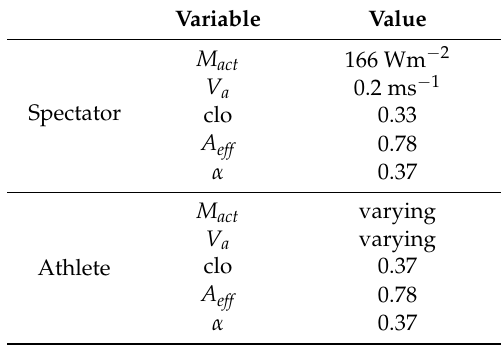
Table 2. Personal inputs used for the spectator and athlete (soccer player) in the COMFA